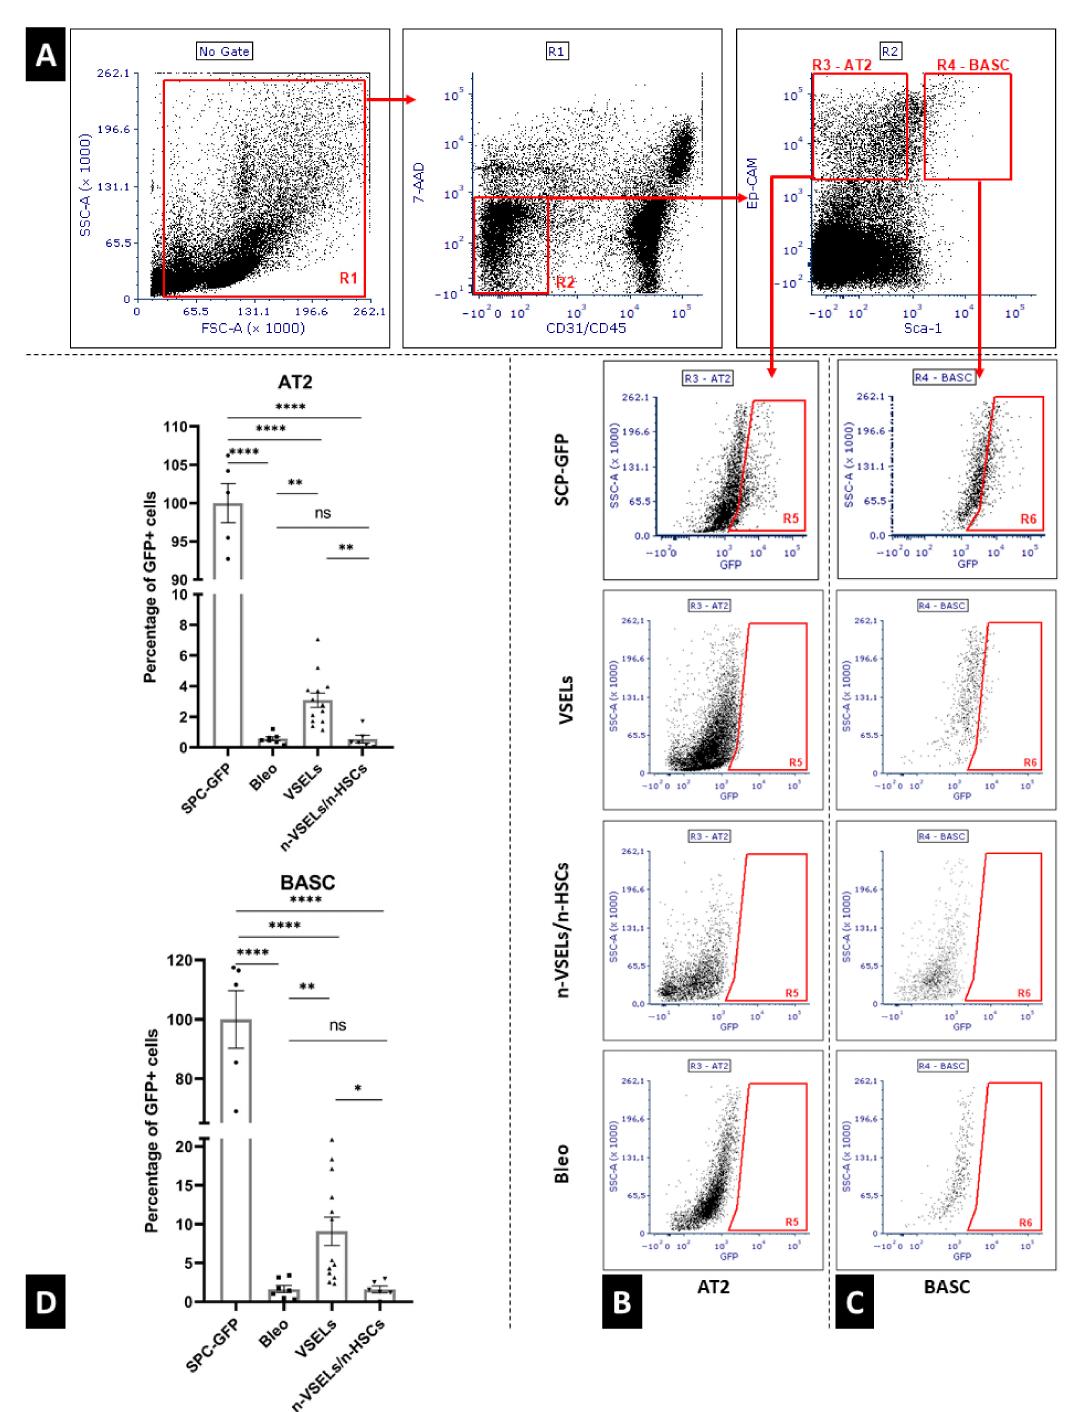
Figure 5. Panel A : gating strategy for flow cytometry analysis of viable (7AAD negative) Alveolar Type 2 cells (CD31 − /CD45 − /Ep-CAM + /Sca-1 − ) and bronchoalveolar stem cells (CD31 − /CD45 − , Ep-CAM + /Sca-1 + ); Panel B : repre- sentative GFP plots for Alveolar Type 2 cells from each mouse group; Panel C : representative GFP plots for bronchioalveolar stem cells from each mouse group. Panel D : quantification of GFP + AT2 (top) and BASC (bottom). Values are standardized to mean GFP positive cells detected in respective population of SPC-GFP donor mice ( n = 5), treated as 100%. Significant differences between experimental groups are indicated with asterisks. Results are from three experiments. Mean and SD indicated by black lines. * p < 0.05, ** p < 0.01, **** p <